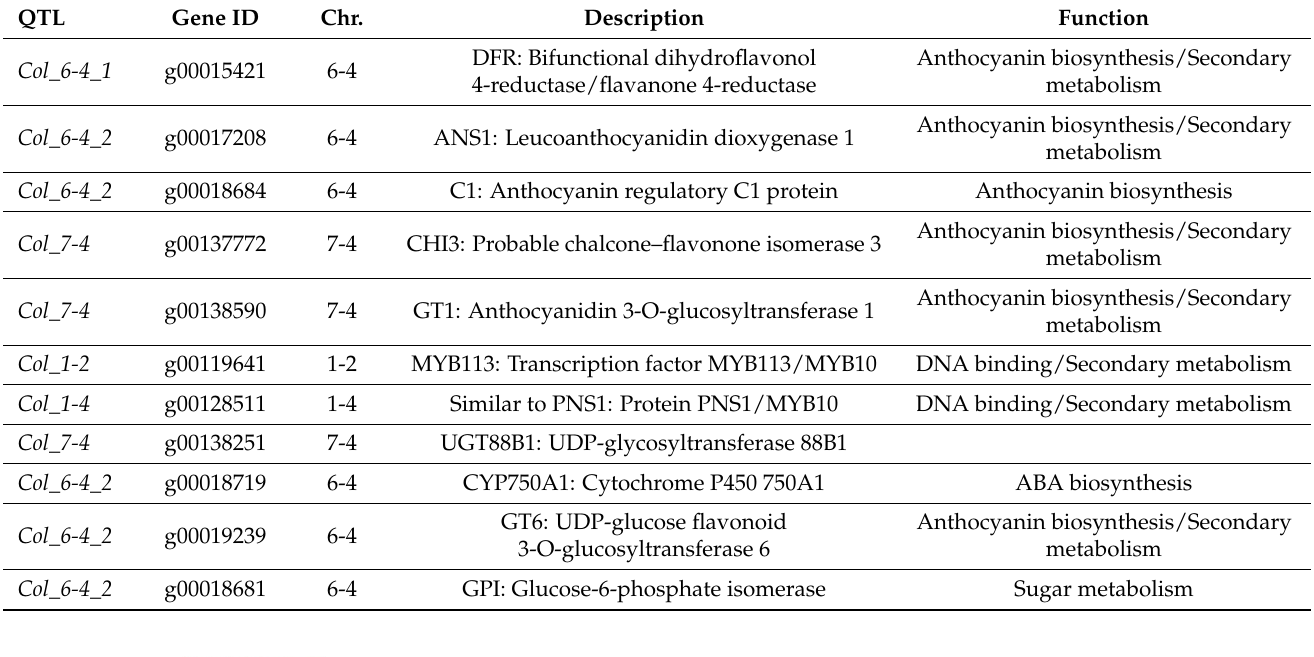
Table 3. Predicted candidate genes in QTLs associated with the fruit color in the ‘BS F 2 (II)’ population.